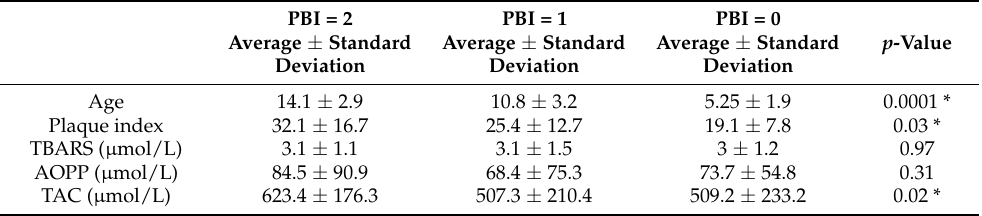
Table 3. Individual PBI relation to oxidative stress markers, age and plaque